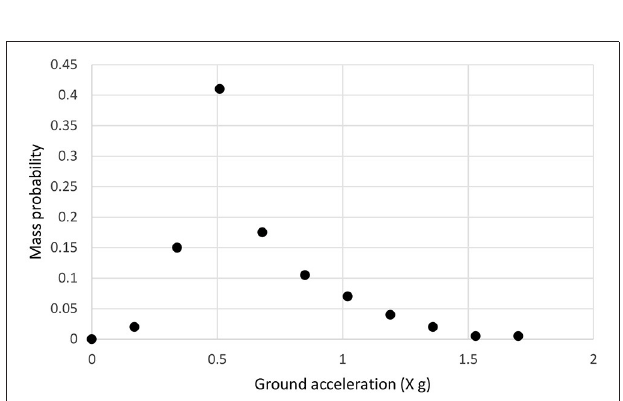
FIGURE 11 | Compensation factors for several actual values of f ′ c, several losses levels, H = 4m and nominal f ′ c = 200 Kg/cm 2 , Acapulco.